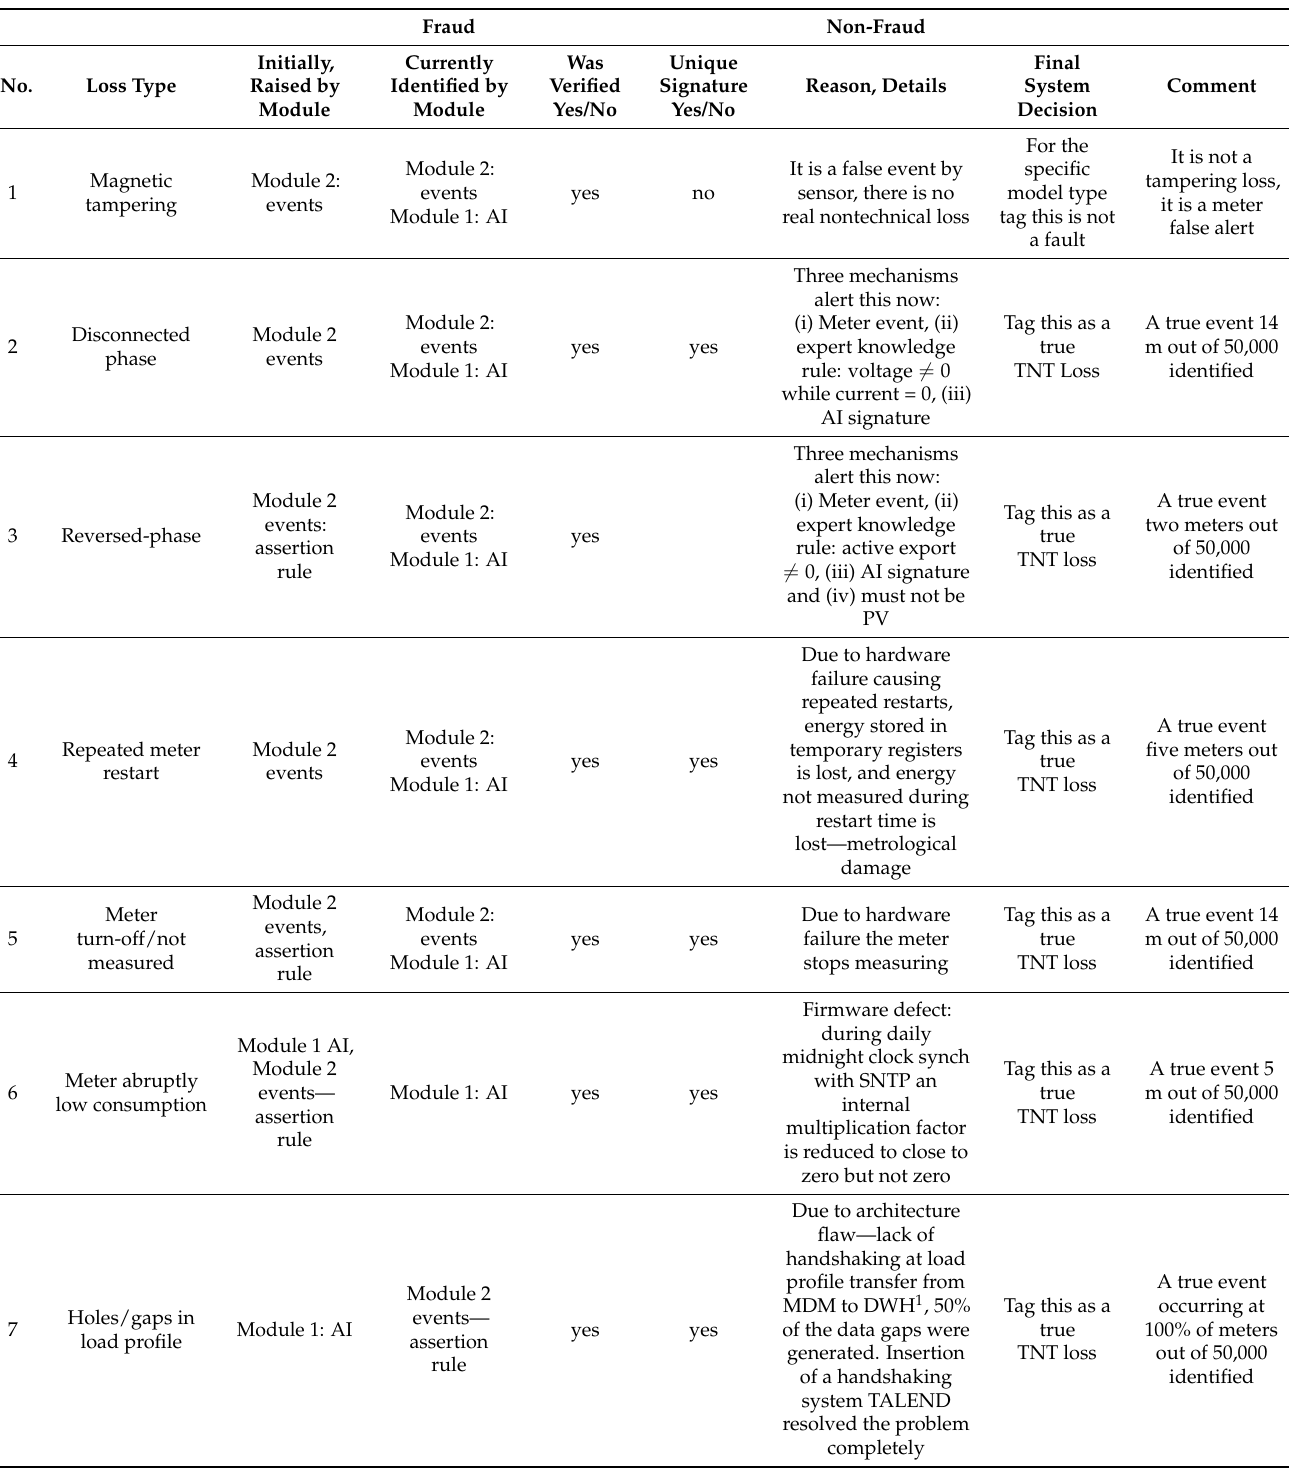
Table 2. Listing down the faults detected by the TNT loss